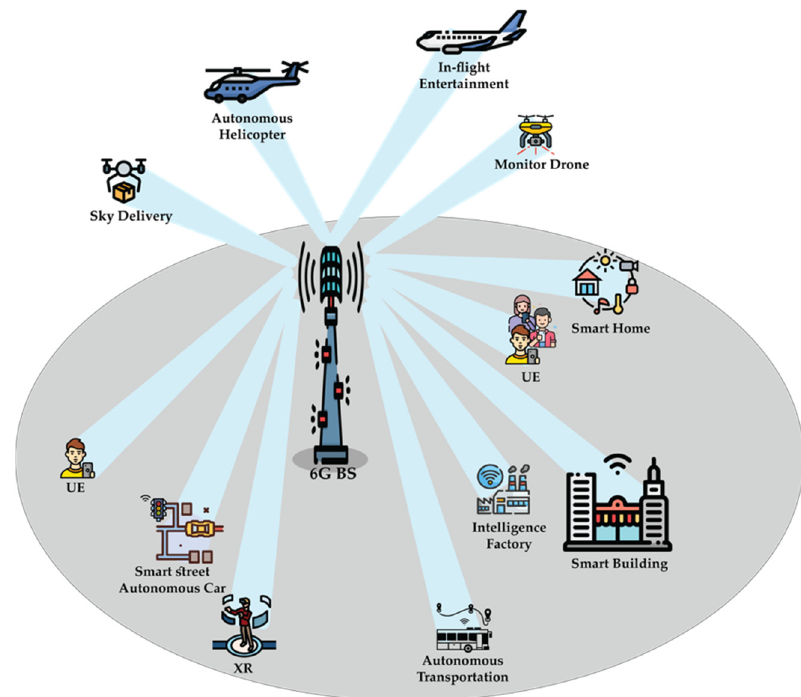
Figure 6. Holographic beamforming.